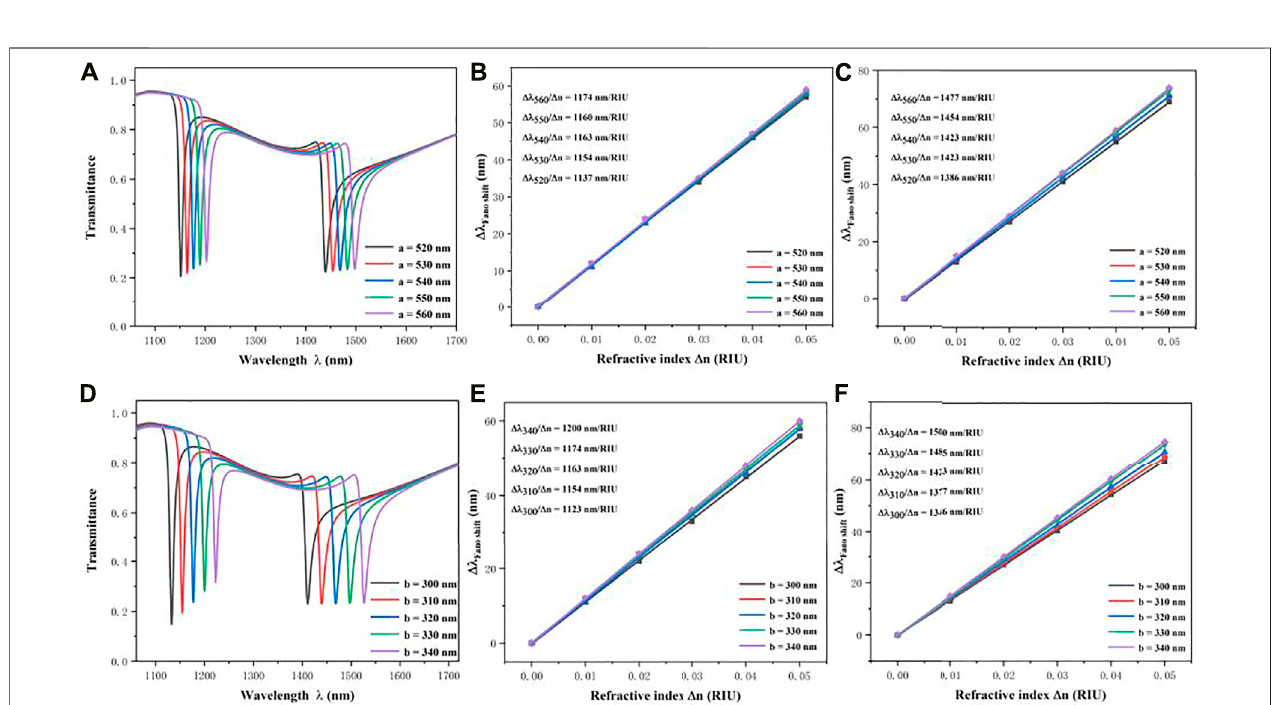
FIGURE 4 | (A) transmission spectra for different a of HNEC; fi tting curve of sensitivity (B) at R2; (C) at R1; (D) transmission spectra for different b of HNEC; fi tting curve of sensitivity (E) at R2; (F) at R1.